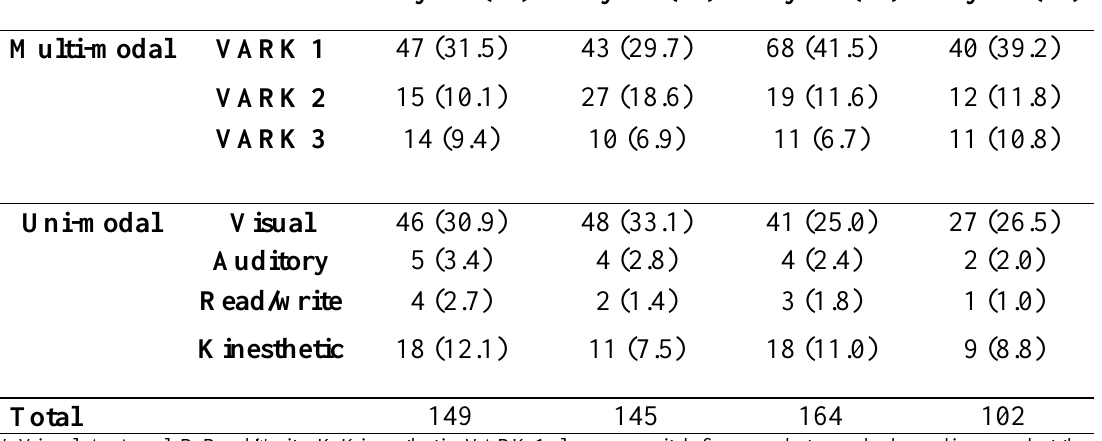
Table 3. Comparison of learning preferences according to academic year